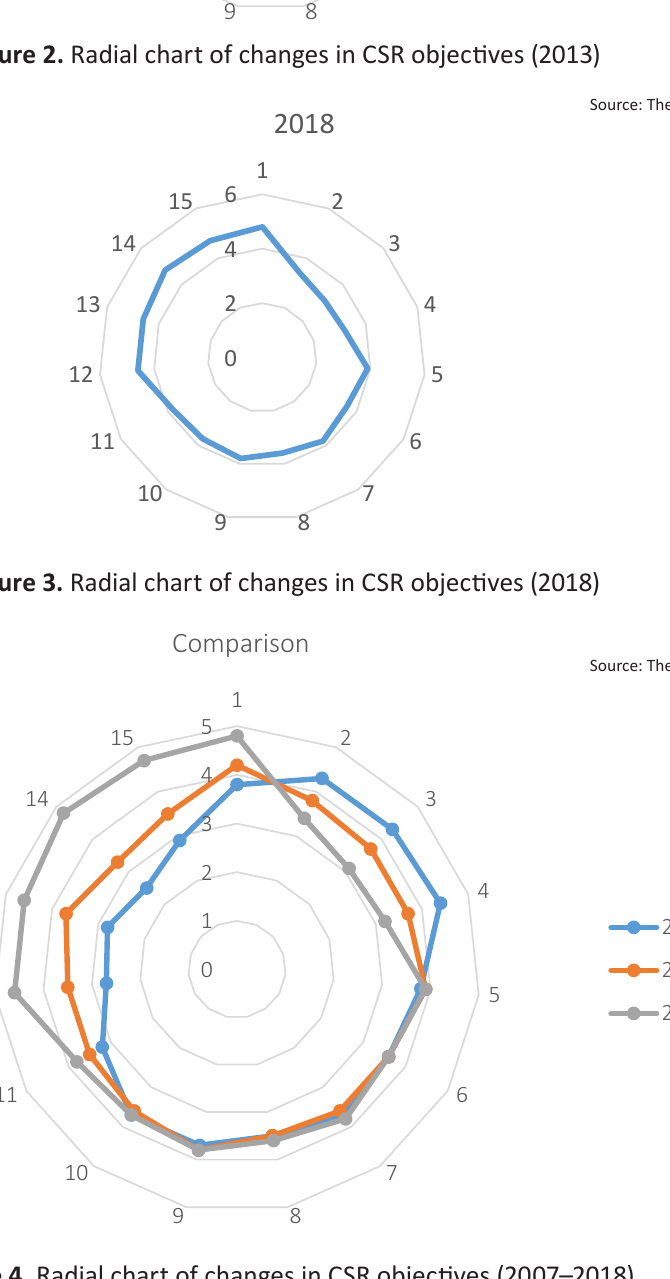
Figure 4. Radial chart of changes in CSR objectives